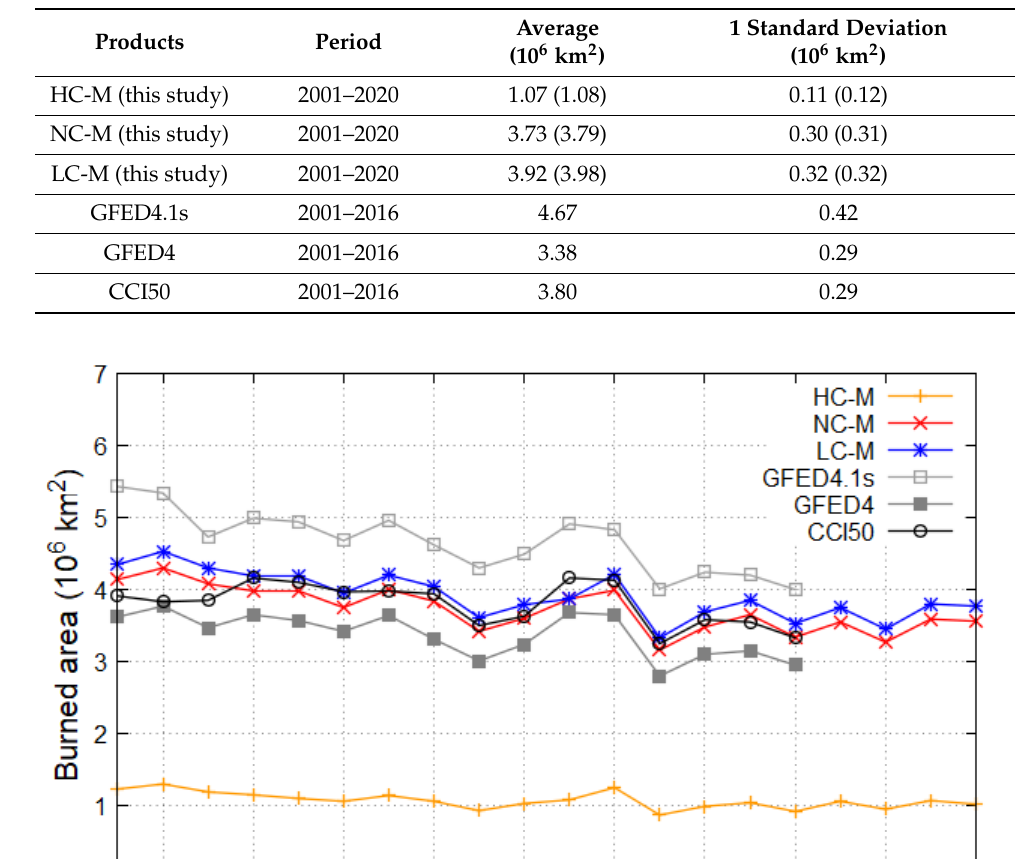
Table 1. Annual global burned area of three results (HC-M, NC-M, and LC-M) from 2001 to 2020 and three previous studies (GFED4.1s, GFED4, and CCI50) from 2001 to 2016. Numbers in parentheses are from 2001 to 2016.